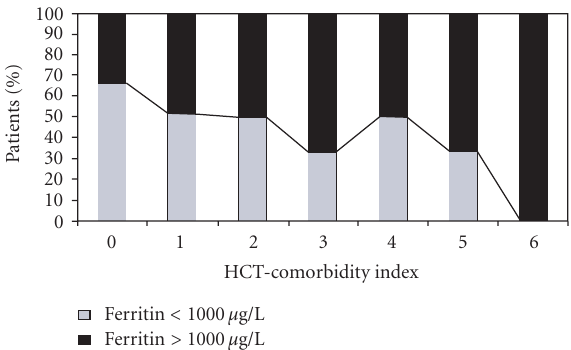
Figure 4: Association of pre-transplantation serum ferritin levels and morbidity [26]. Comorbidity index: 0 = low risk, 1 to 2 = intermediate risk, 3 or more = high